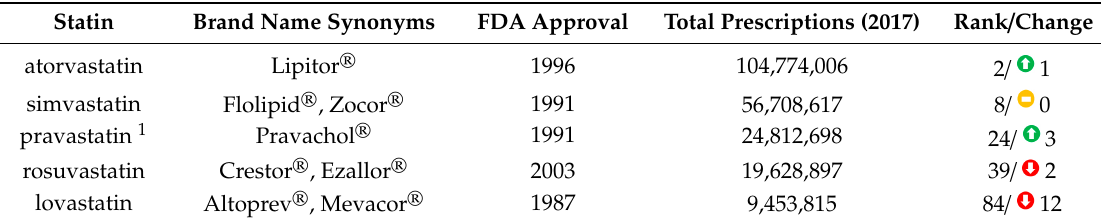
Table 1. A summary of basic information about the most prescribed compounds from the statins class